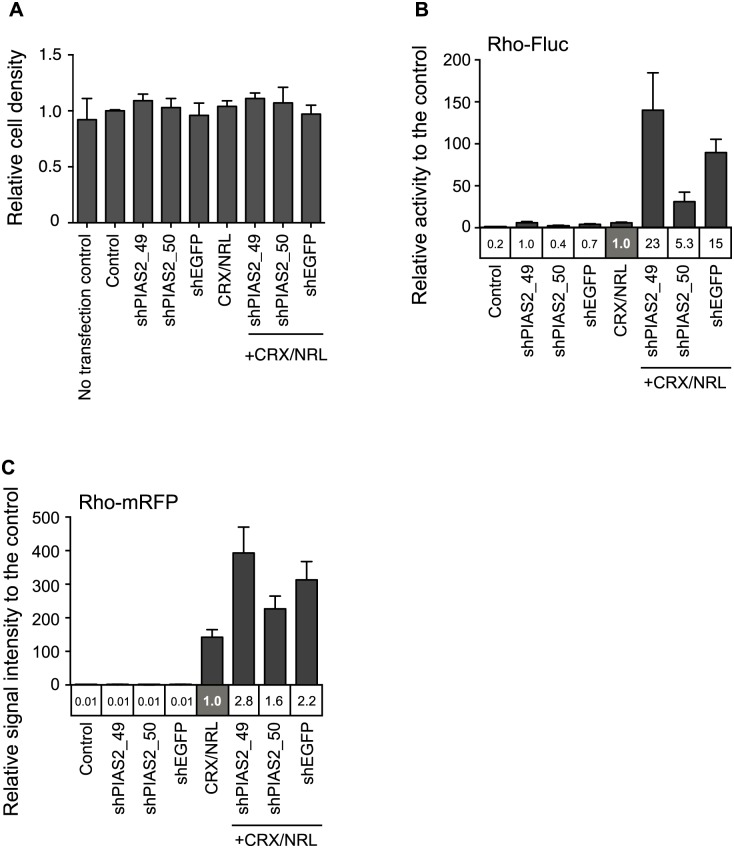
shRNAs do not regulate reporter activity by mediating CRX/NRL expression, cell density, and reporter stability.(A) Relative cell density for shRNA transfected cells. HEK293 cells were transfected with indicated shRNAs in combination with CRX, and NRL expression vectors. Two days after the transfection, the nuclei of the cells were stained with Hoechst 33342 and imaged with the Cellomics Vti High Content Imaging system. The cell density was quantified using Target Activation BioApplication. Relative cell density was presented as the ratio to the cell density of the control. (B, C) The effect of shRNA on rho-Fluc (B) and rho-mRFP (C) reporters. HEK293 cells were transfected with the reporter and the indicated shRNAs with or without CRX and NRL expression vectors. As a control, 500 ng of empty pcDNA3 vector with 100 ng reporter vector was transfected into HEK293 cells. Two days after the transfection, Firefly luciferase activity and mRFP fluorescent intensity were measured. Relative luciferase activity to the control (bar graph) and the CRX/NRL transfected sample (in the column under the bar graph) are presented. Error bars are shown as SE.